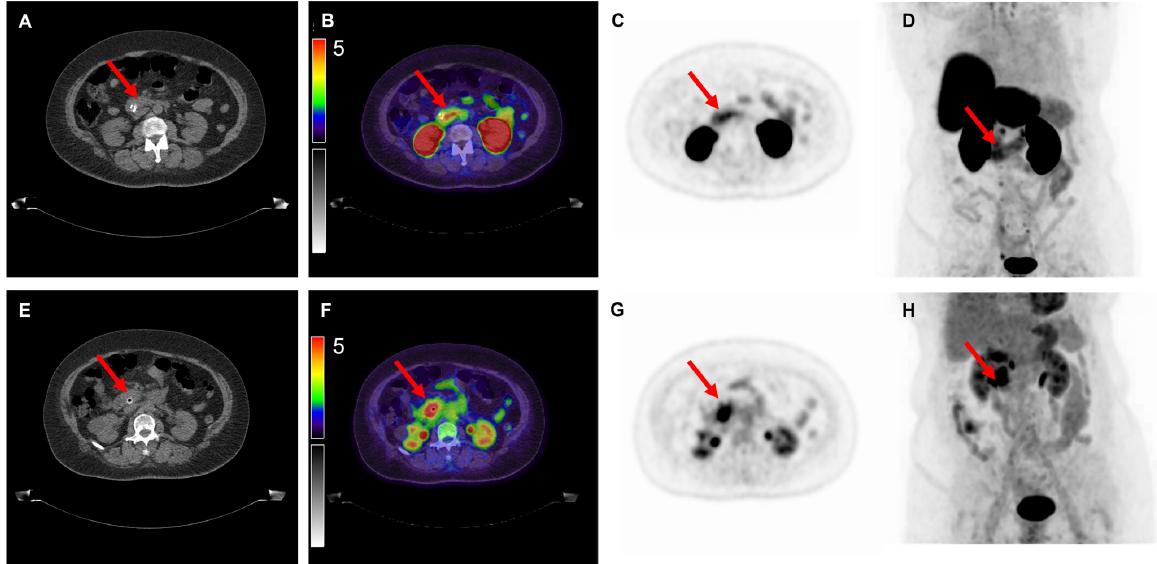
Figure 3. Overview of imaging modalities of a patient with pT2N2M0 pancreatic ductal adenocar ‐ cinoma (patient 10). The arrows indicate ( upper row ) a lesion with moderate to intense [ 18 F]DCFPyL expression with an SUV max of 5.1 and ( bottom row ) a lesion with [ 18 F]FDG uptake with an SUV max of 10.1. From left to right: low ‐ dose CT ( A , E ), fused PET/CT ( B , F ), PET ( C , G ), and the maximal in ‐ tensity projection (MIP, ( D , H )). Image scale SUV 0 ‐ 5.